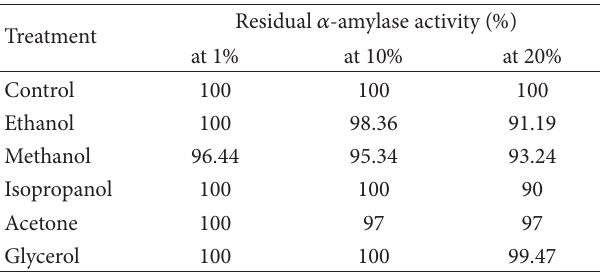
T 5: Effect of different solvents and other chemicals on the puri- �ed -amylase enzyme activity produced by Bacillus licheniformis AI20. 𝛼𝛼